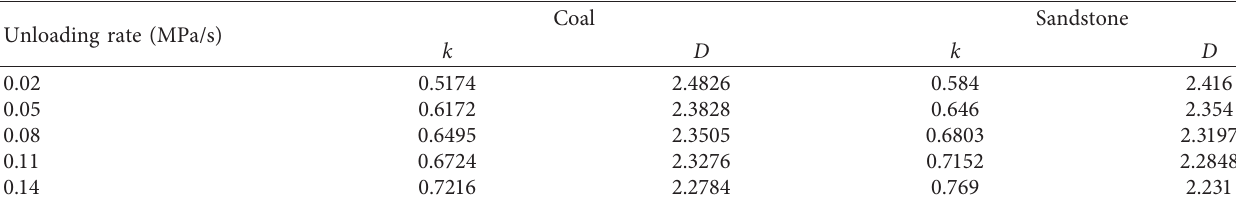
Table 9: Fractal dimension of fragmentation under different unloading